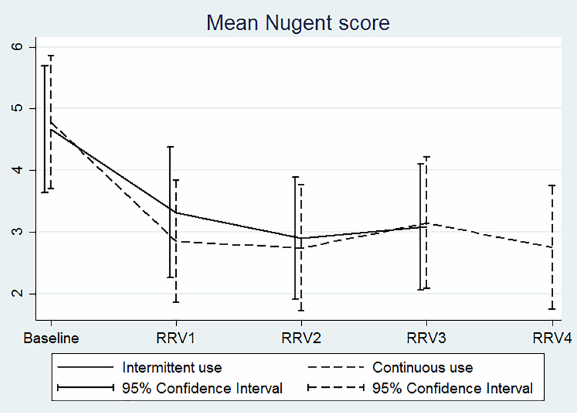
Fig 2. Mean Nugent score over time by randomisation group. X-axis: RRV = ring removal visit.Y-axis: Mean Nugent score for intermittent users (solid line) and continuous users (dashed line) with bars indicating 95% confidence intervals. The mean Nugent score for the 60 women in each randomisation group was calculated at baseline and at each ring removal visit. The intermittent users used three rings and therefore had three ring removal visits, whereas the continuous users had